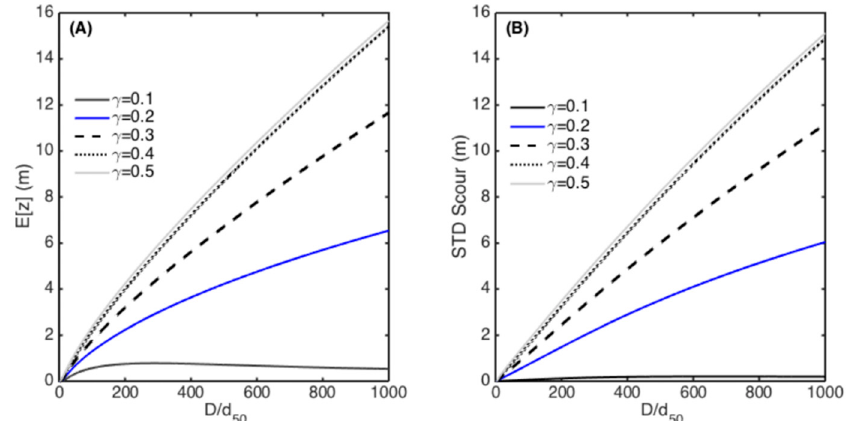
Figure 6. Mean ( A ) and standard deviation ( B ) of scour obtained with the proposed framework for different cross-sections, obtained by modifying the shape parameter of the cross-section γ . Other parameters are: D = 1.07 m; d 50 = 0.001 m; ρ s = 2.65 t/m 3 ; u c = 0.319 m/s; λ = 4.7252 × 10 3 ; W * max = 1.8613 × 10 5 ; S = 8.90; α = 67.86 m 3 /s; b 1 = 143.64; ξ = 0.30 1/m 2 and k = 60 min.